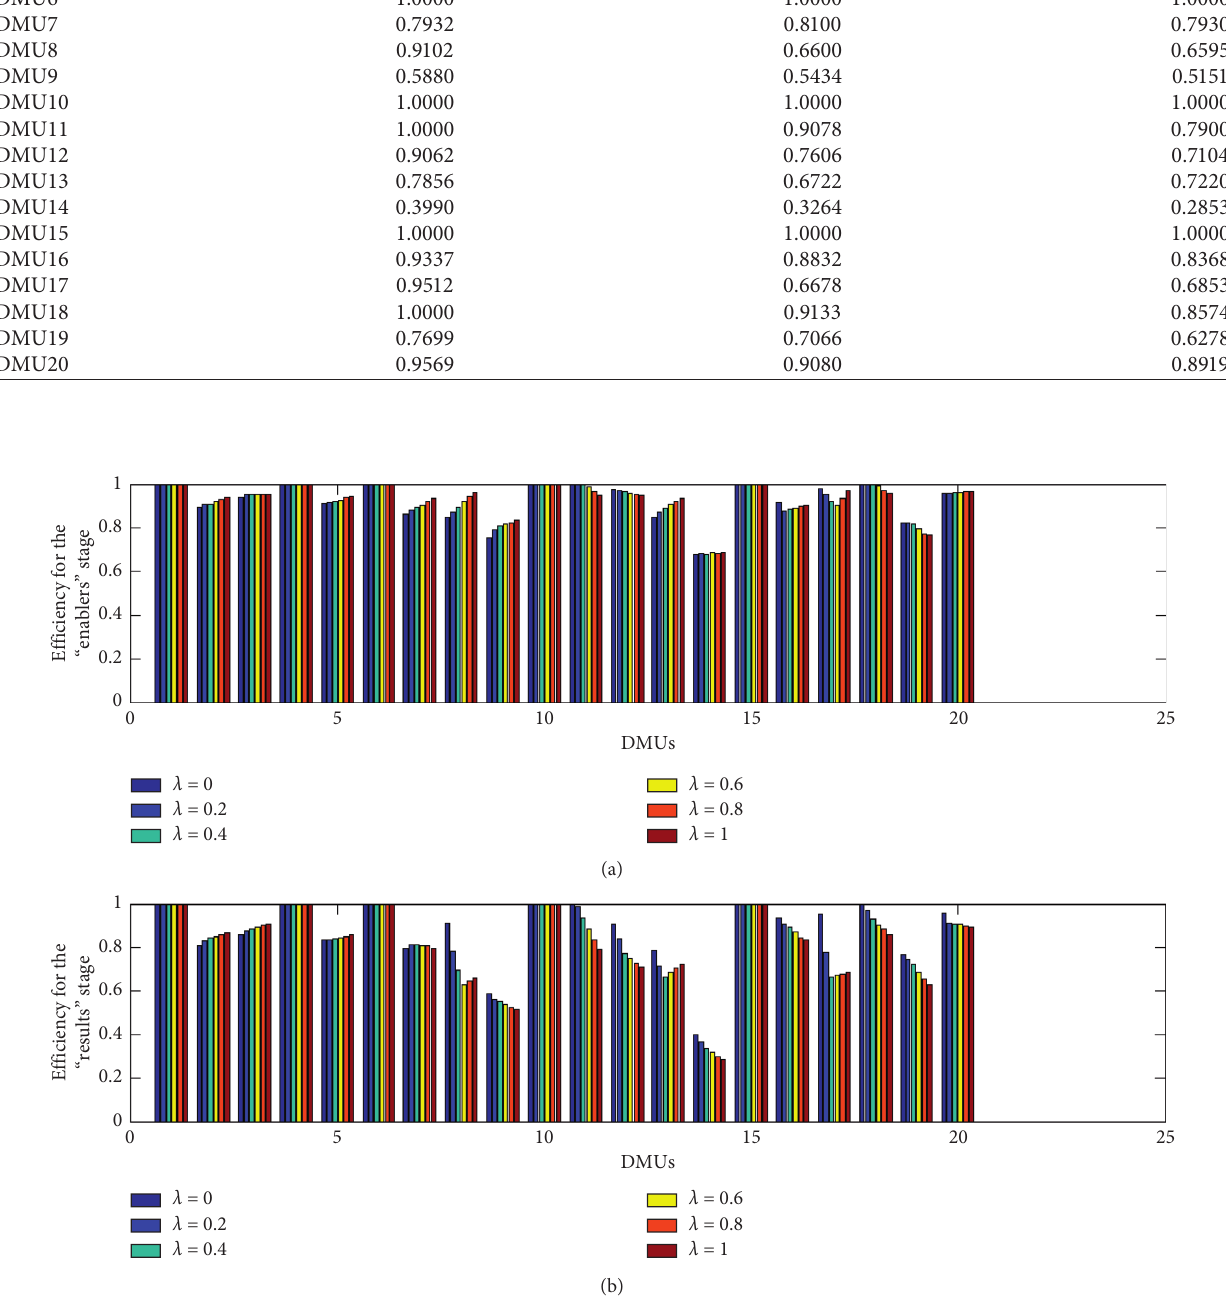
Figure 5: The relative efficiency of DMUs for enablers and results